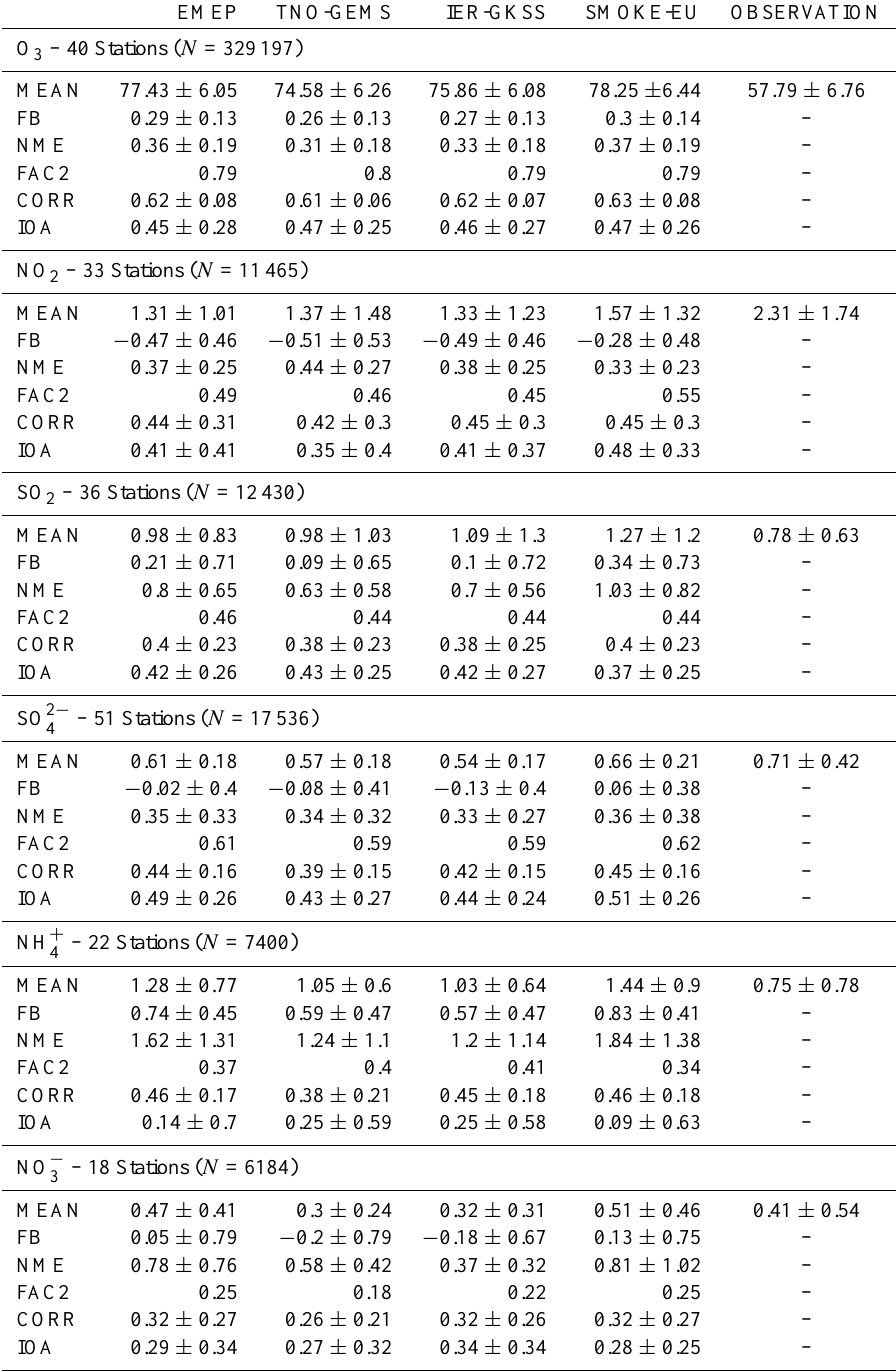
Table 5. Statistical comparison of CMAQ results using four different emission datasets. Values are averages over all measurement stations and their standard deviations. For more detailed results, see Figs.